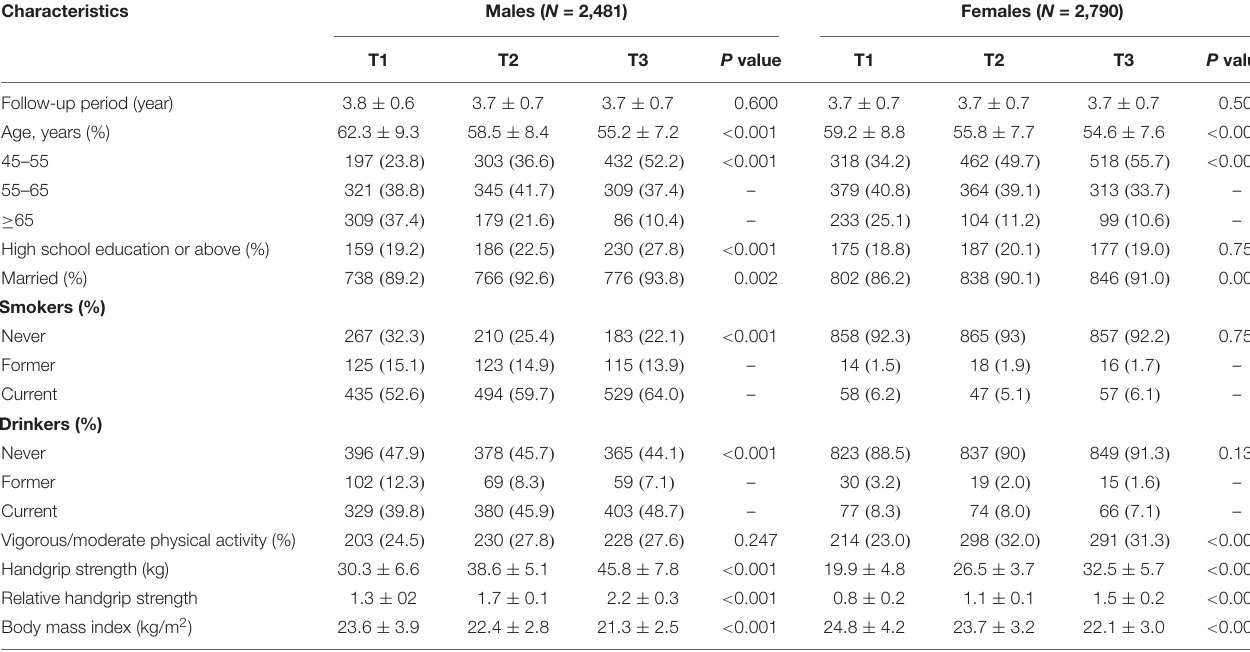
TABLE 1 | Characteristics of all participants by relative handgrip strength groups*. Characteristics